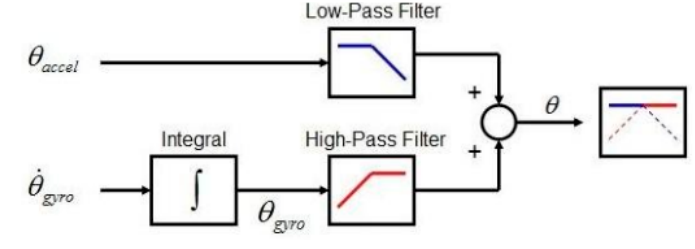
Figure 15. Structure of the complementary filter.